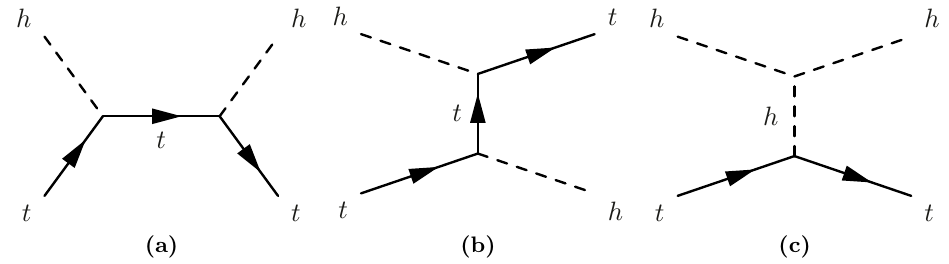
Figure 38. SM diagrams for the th